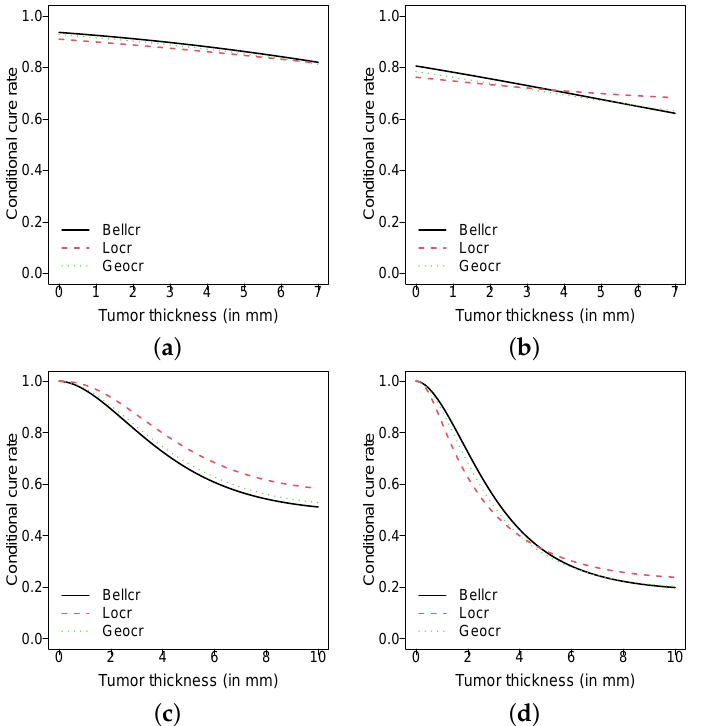
Figure 6. Estimates of the conditional cure rate ( p t ulceration and ( b ) with ulceration. Estimated survival function for a tumor thickness of 10 cms: ( c ) without ulceration and ( d ) with